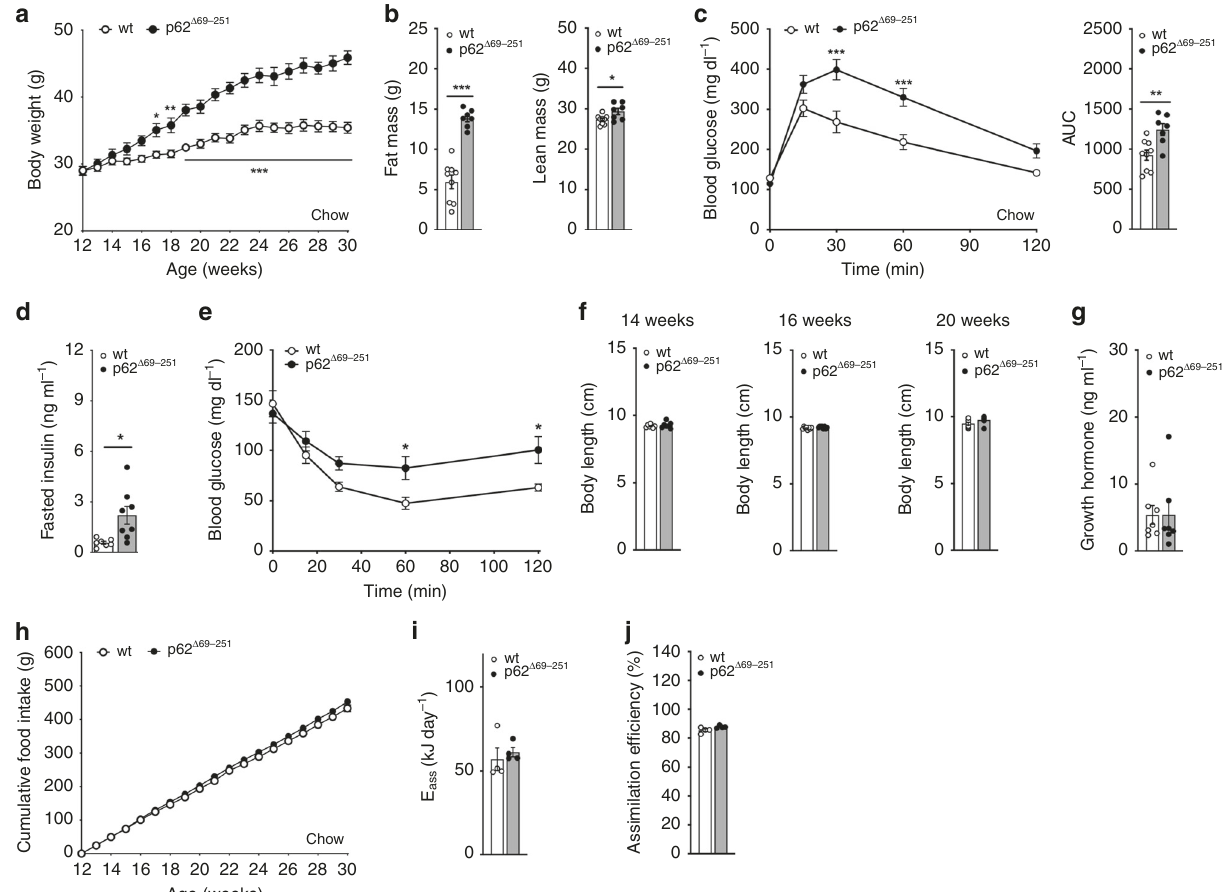
Fig. 1 Metabolic phenotype of chow-fed male p62 Δ 69-251 mice. Body weight development ( a ) as well as body composition ( b ) and glucose tolerance ( c ) in 31-wk-old male C57Bl/6J wt or p62 Δ 69-251 mice. Fasted insulin levels ( d ) and insulin sensitivity ( e ) in 24-wk-old male mice. Body length at the age of 14, 16, or 20 wks ( f ). Growth hormone at the age of 14 wks ( g ). Cumulative food intake ( h ) as well as assimilated energy ( i ) and assimilation ef fi ciency ( j ) at the age of 30 wks. Sample sizes are ( a – c ) n = 9/7 mice, ( d , e ) n = 7/8 mice, ( f ) n = 7/7 mice, n = 8/8 mice, n = 8/8 mice, ( g ) n = 7/7 mice. Cumulative food intake ( h ) was assessed per cage in n = 6/4 cages containing n = 9/7 mice. For panels ( i ) and ( j ), feces were collected per cage in n = 4/4 cages containing n = 8/8 mice. Data represent mean ± SEM. Longitudinal data in panels ( a ), ( c ), ( e ), and ( h ) were analyzed using two-way ANOVA with time and genotype as co-variant and using Bonferroni post hoc multiple comparison analysis for differences at individual time points. Bar graphs in panels ( b ), ( c ), ( d ), ( f ), ( g ), ( i ), and ( j ) were analyzed using two-sided two-tailed t -test. * p < 0.05; ** p < 0.01; *** p < 0.001. Exact p -values are ( a ) d17 p = 0.0318, d18 p = 0.0125, d19 p < 0.0001, d20 p = 0.0002, d21 – d30 p < 0.0001; ( b ) p = 0.000001996 and p = 0.0228; ( c ) 30 min p < 0.0001, 60 min p = 0.0004; AUC p = 0.00467; ( d ) p = 0.0132; ( e ) 60 min p = 0.0237, 120 min p = 0.0358. AUC area under curve, E ass assimilated